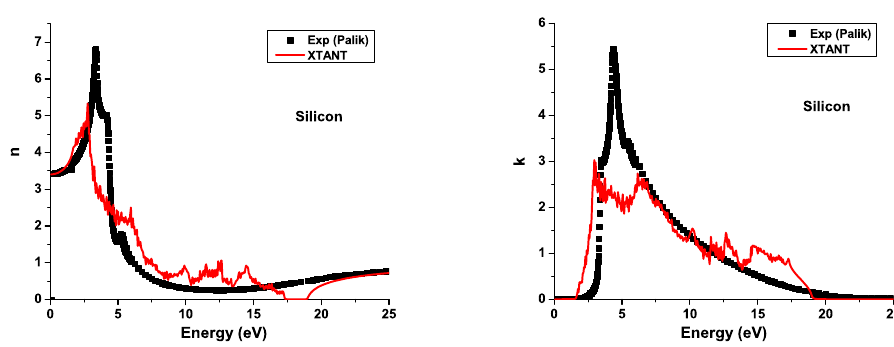
Figure 2. Optical refractive indices n ( left ) and k ( right ) of the equilibrium silicon. The dots are experimental data [22]; the solid line is TB model prediction with XTANT-2 (64 atoms in the simulation cell, 2197 (13 × 13 × 13) k -points).